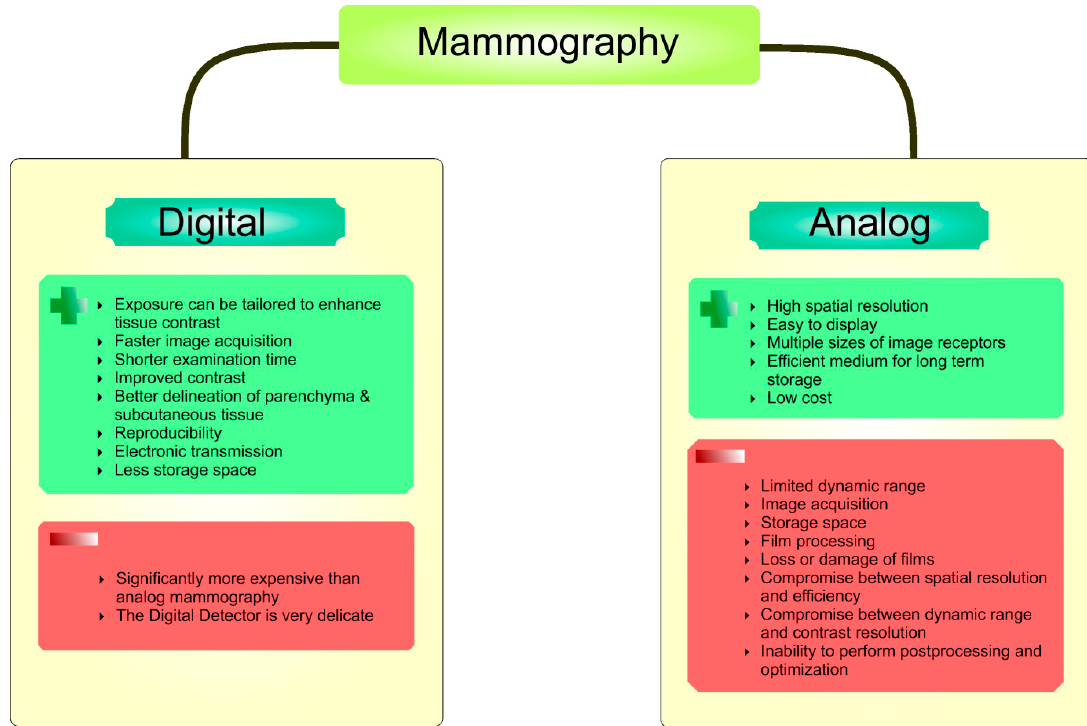
Figure 2. Advantages and disadvantages of digital versus analog mammography.